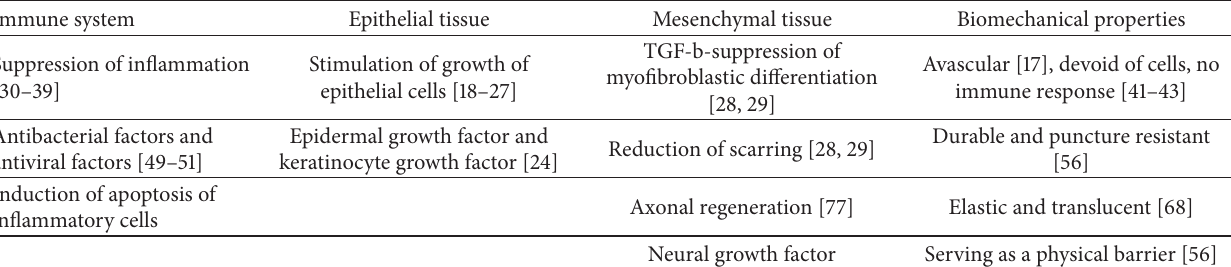
Table 2: Properties and mechanism of action of amnion